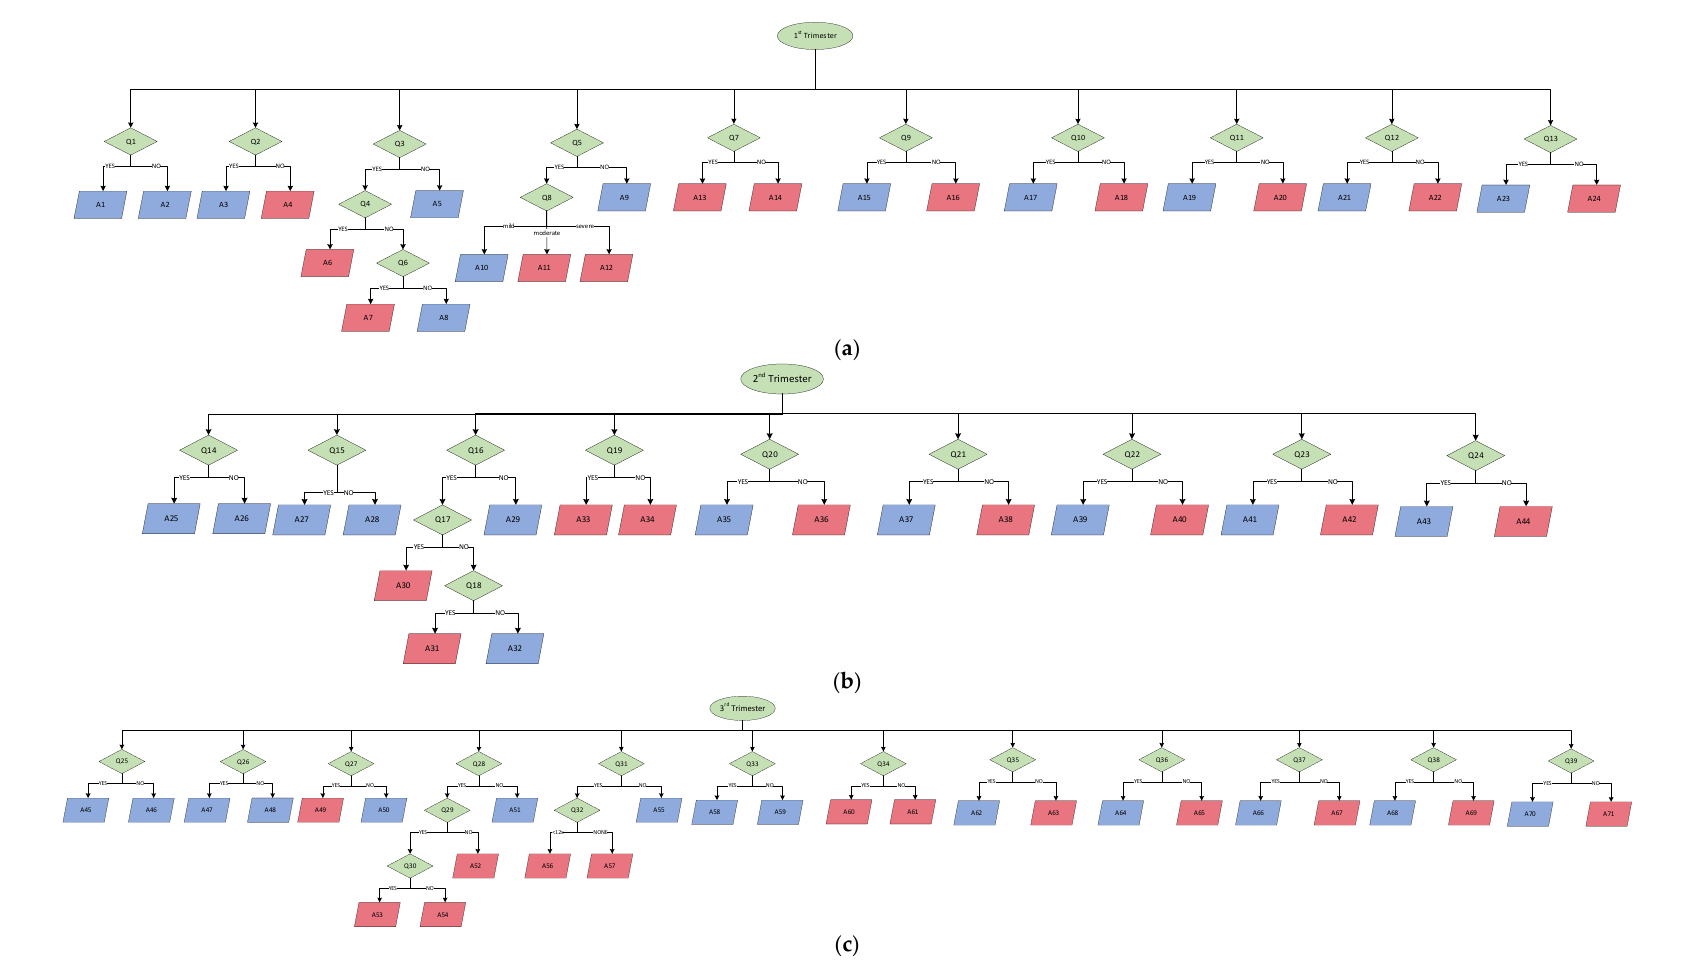
Figure 8. ( a ) Decision tree of the semi-automated chatbot for 1st Trimester. ( b ) Decision tree of the semi-automated chatbot fo r 2nd Trimester. ( c ) Decision tree of the semi-automated chatbot for the 3rd Trimester.